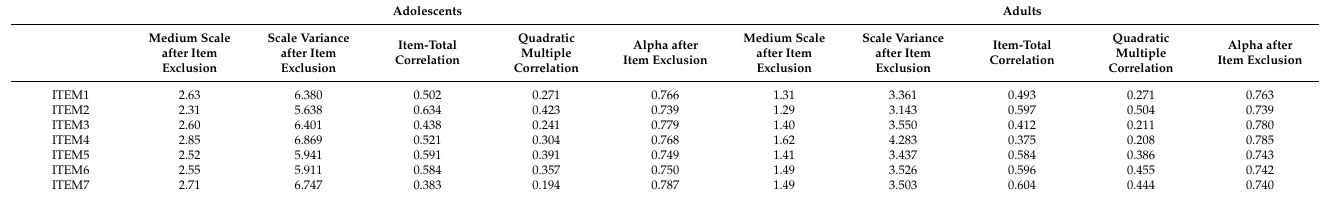
Table 3. Alpha deleted analysis of the ARI scale in the adolescent and adult population.